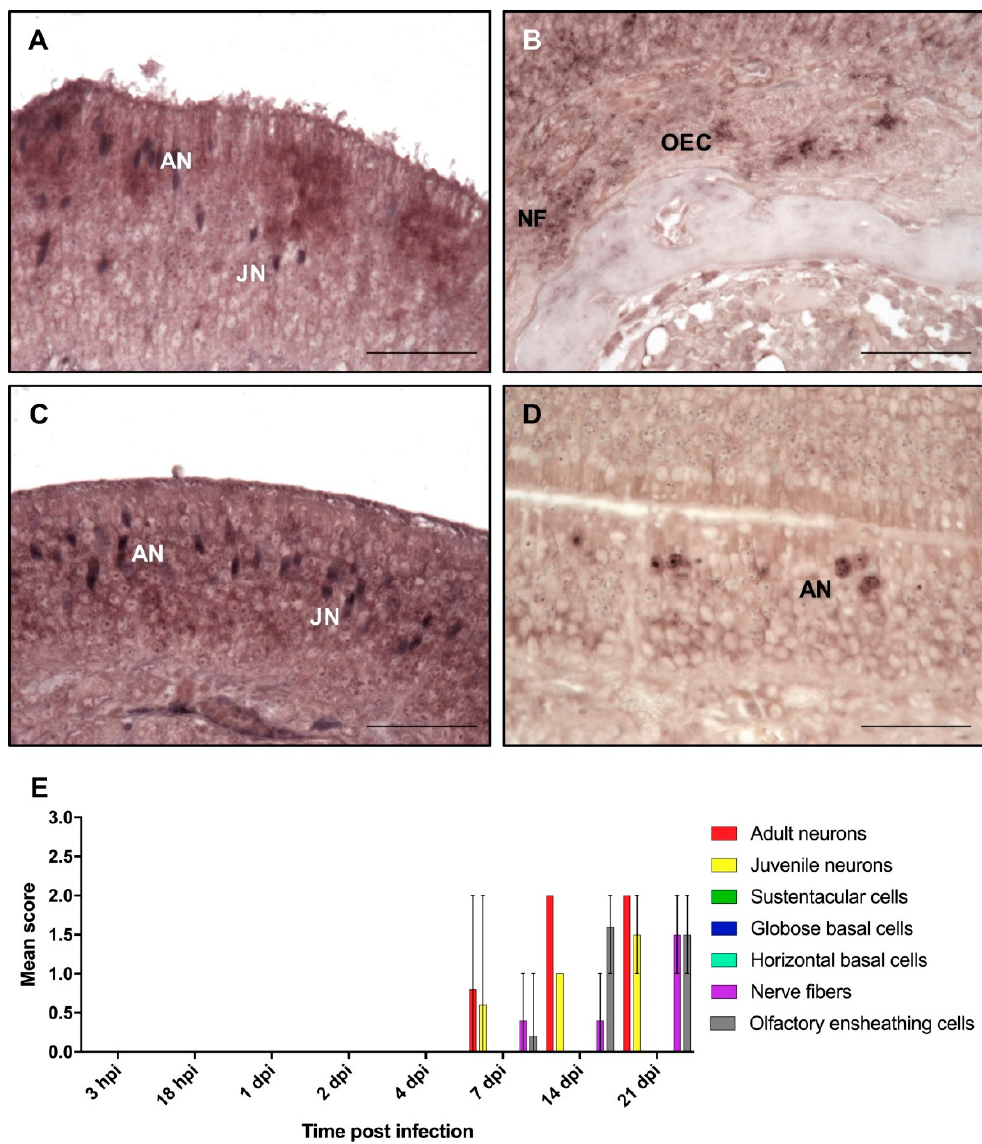
Figure 2. In situ hybridization for the detection of viral genomic RNA in the OM. At ( A ) 7 dpi; ( B ) OECs and nerve fibers located in the lamina propria at 7 dpi; ( C ) 14 dpi; ( D ) 21 dpi. AN—adult neurons; JN—juvenile neurons; NF—nerve fibers; OEC—olfactory ensheathing cells. Scale bar ( A – D ): 50 µm. ( E ) Mean score of in situ hybridization: arithmetic mean; error bars: min/max.